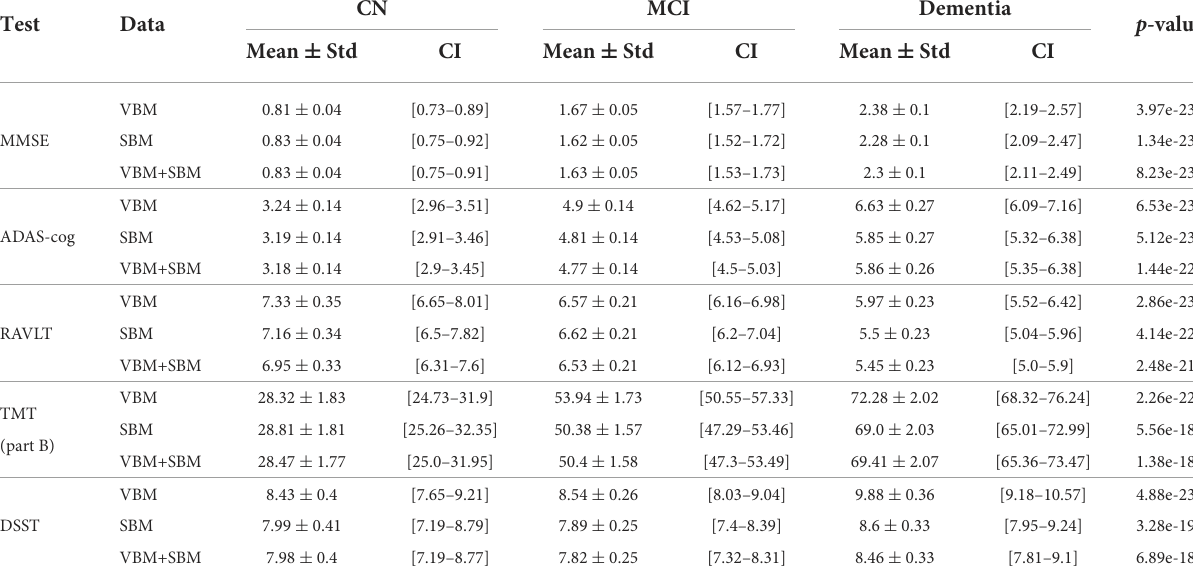
TABLE 4 Metrics of models trained on cognitively preserved population, subjects diagnosed with MCI or dementia